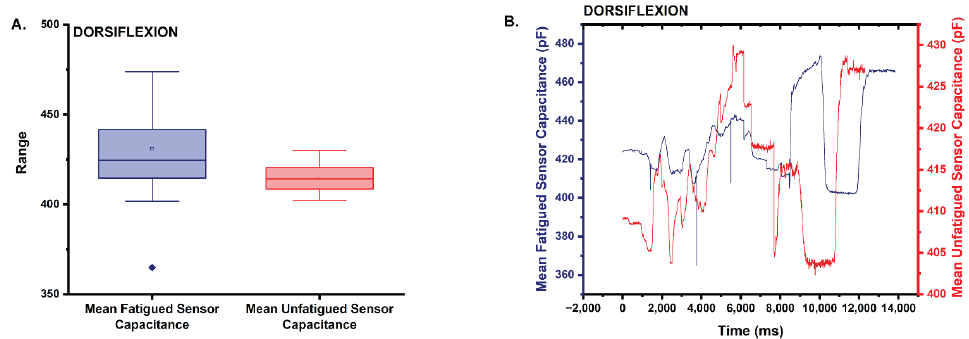
Figure 8. ( A ) Box plot of the statistics comparing the mean capacitance of the fatigued sensor to that of the unfatigued sensor in dorsiflexion. Note that the mean capacitance is higher for the fatigued sensor. ( B ) Plot comparing the mean capacitance of the fatigued sensor to the unfatigued sensor during the dorsiflexion trials.